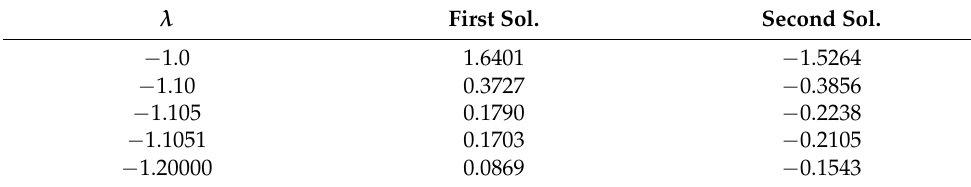
Table 4. The smallest eigenvalues γ 1 with assorted λ